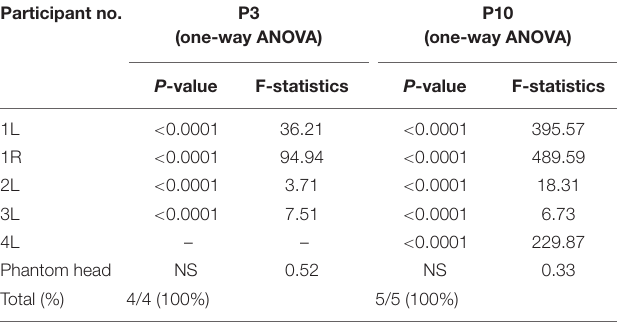
TABLE 1 | Effect of MICC on P3 and P10